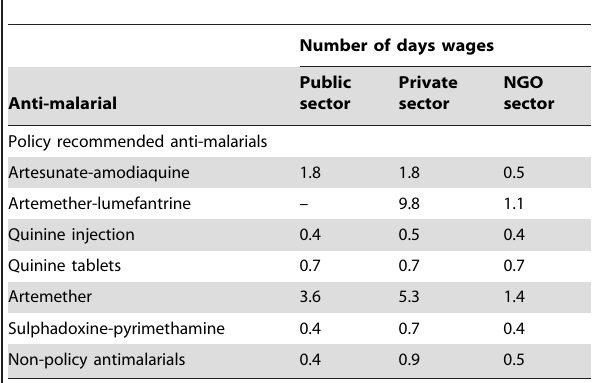
Table 4. Affordability of policy and non-policy antimalarials when purchasing the medicines in the public, private, and charitable